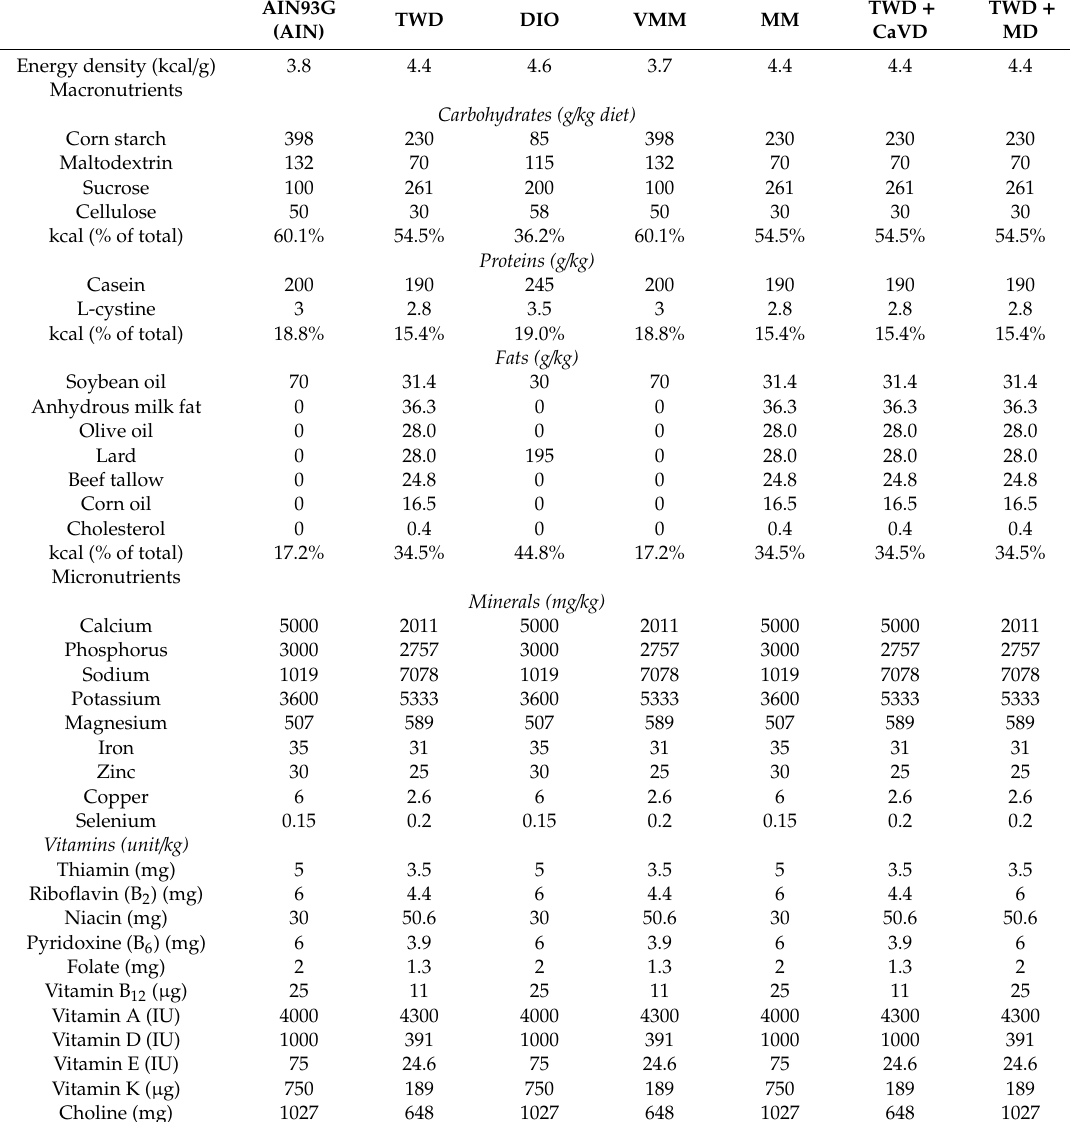
Table 1. Composition of experimental